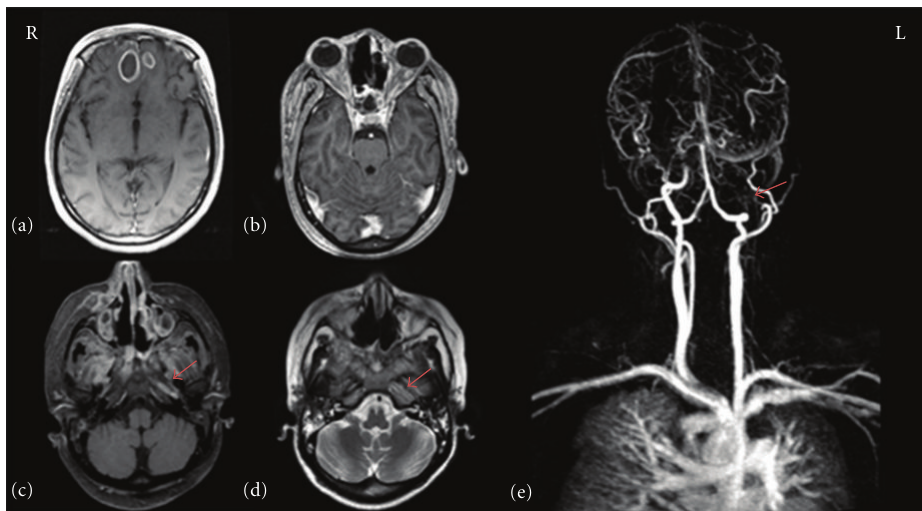
Figure 1: (a) MRI brain, axial T1 weighted image with gadolinium depicting anterior frontal bilateral abscesses. (b) MRI brain, axial T1 showing the orbital disease. (c) MRI brain, axial T1 demonstrating gadolinium enhancement around the left carotid artery canal. (d) T2 axial image demonstrating the absence of signal void at the left carotid artery. (e) MR angiography depicting complete occlusion of the left internal carotid artery cervical and cranial base